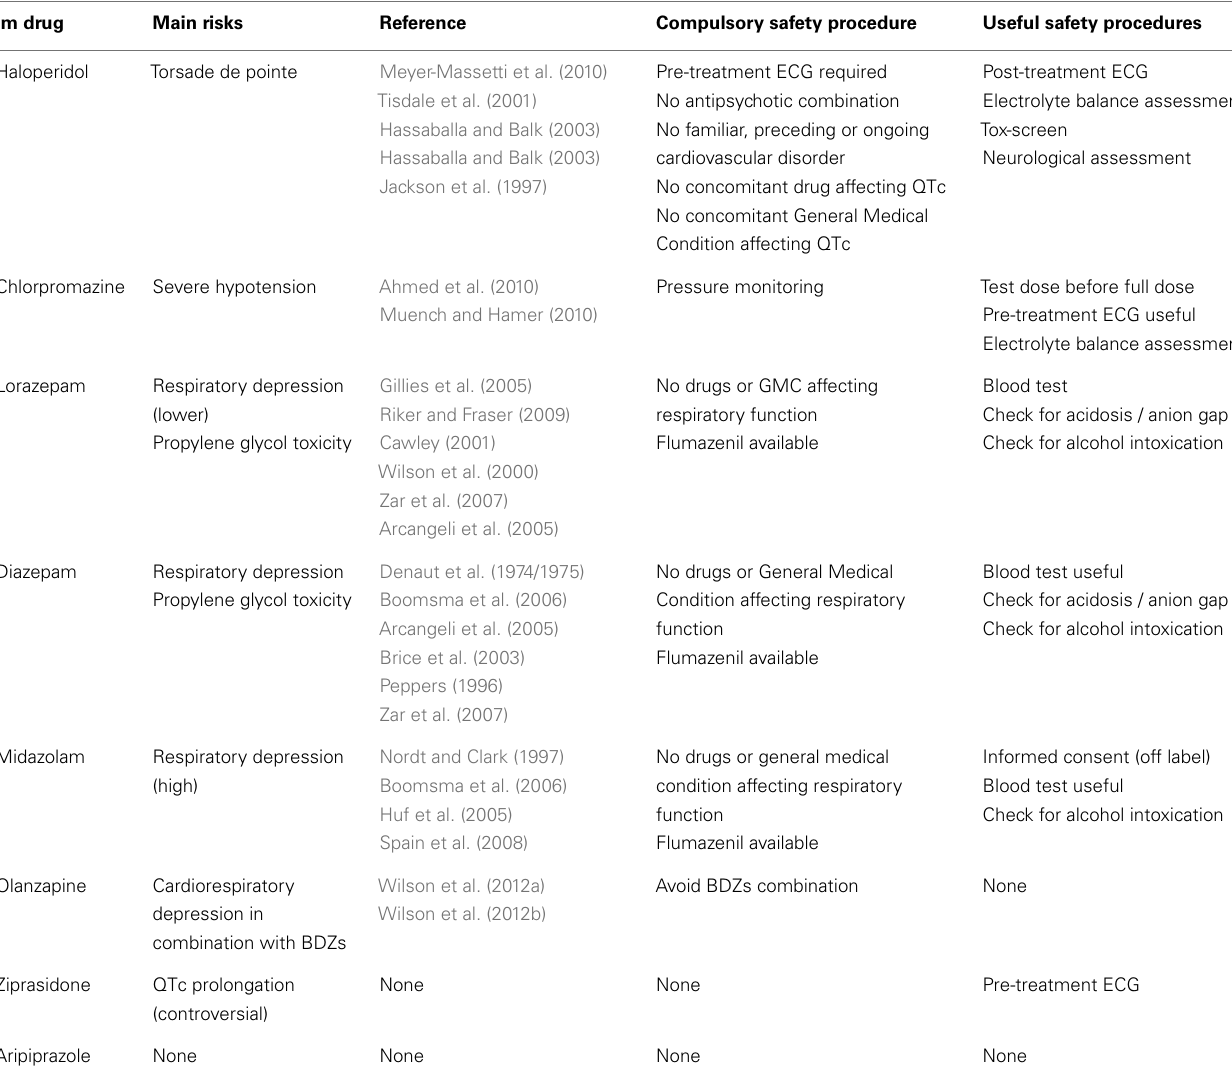
Table 2 | Safety procedures (required or suggested) to reduce the risk of severe adverse effects during IM treatment of agitation.